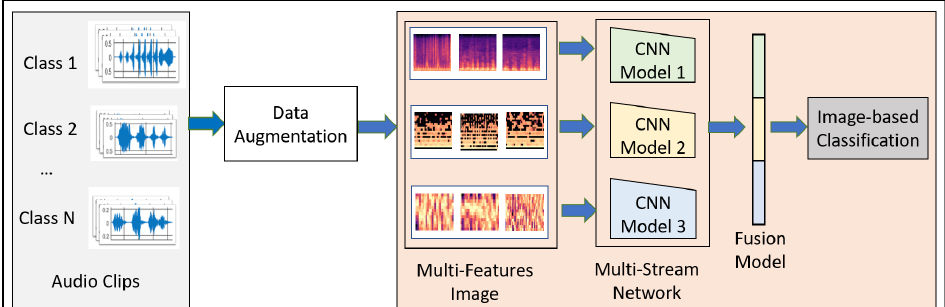
Figure 1. Fusion-Based Disease Classification Architecture.